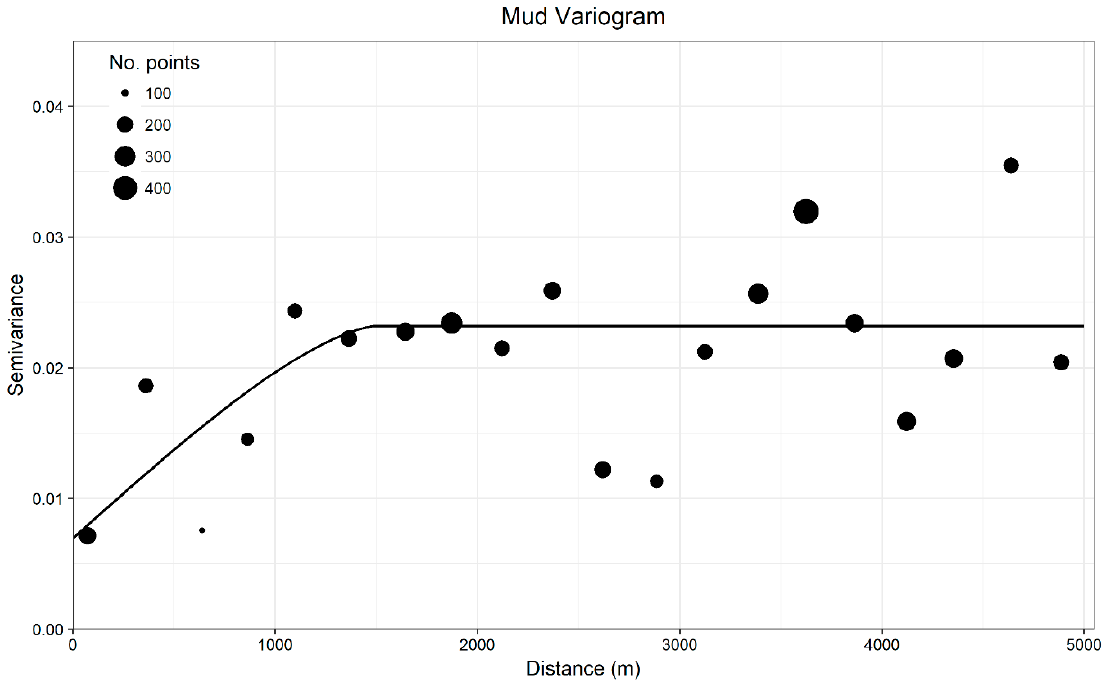
Figure A1. Mud fraction variogram circular model with 250 m lags; nugget = 0.0069, partial sill = 0.0162, major range = 1496.63 m.